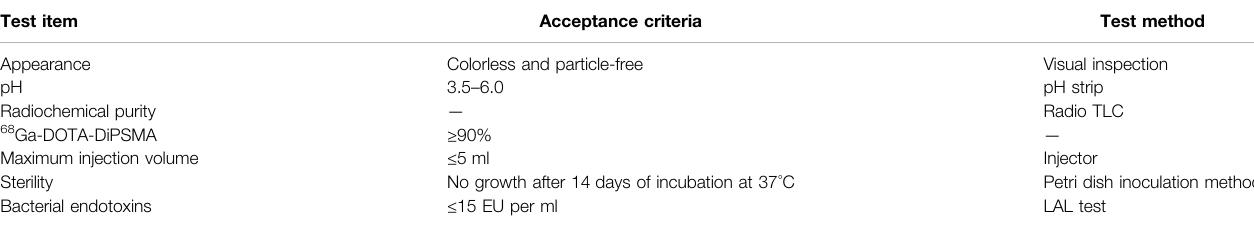
TABLE 2 | Quality control test items.